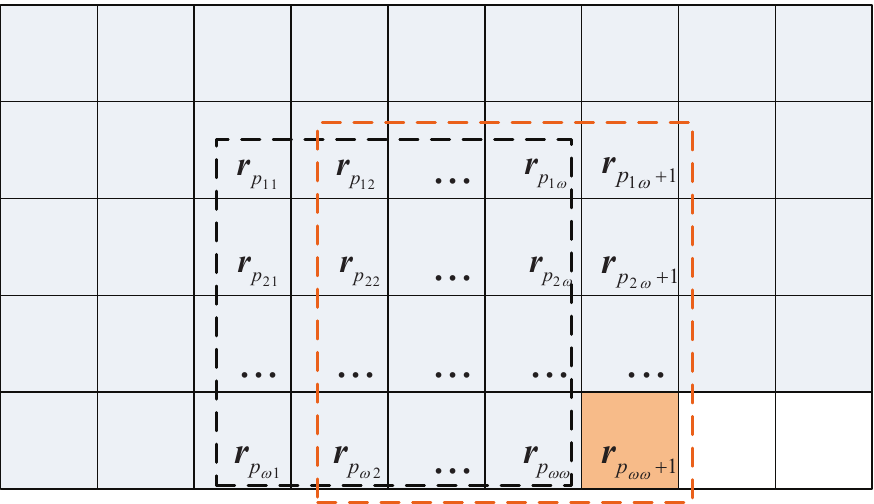
Figure 3. Sliding window with size of ω × ω